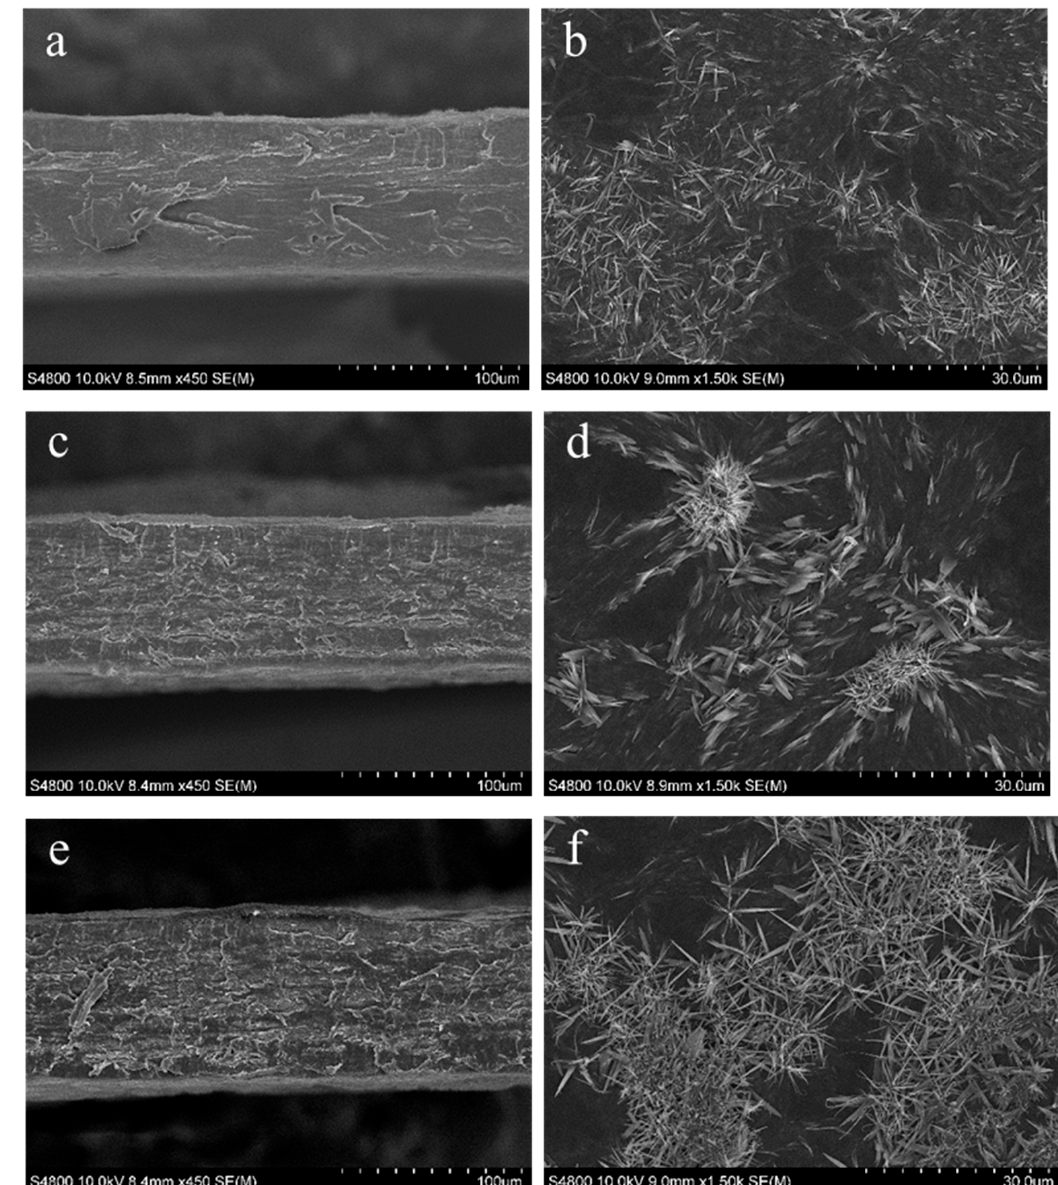
Figure 4. SEM images of cross-section (left hand) and surface (right hand) of control ( a , b ) and thermally treated films at 90 °C ( c , d ) and 105 °C ( e , f ).